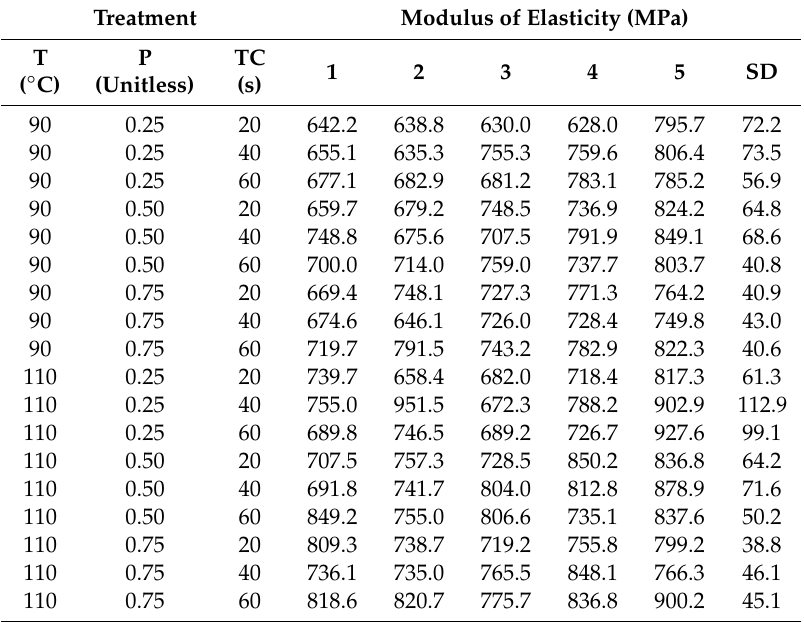
Table 10. Results for modulus of elasticity in rice husk and pine sawdust briquettes. Treatment